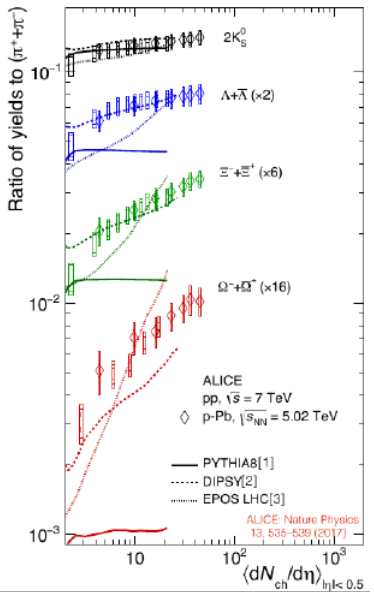
Figure 5. Ratio of strange yields to π + + π − in pp, p-Pb a a function of average particle multiplicity. A smooth transition is observed as a function of particle multiplicity connecting the small (pp) and larger (pPb) systems [22].